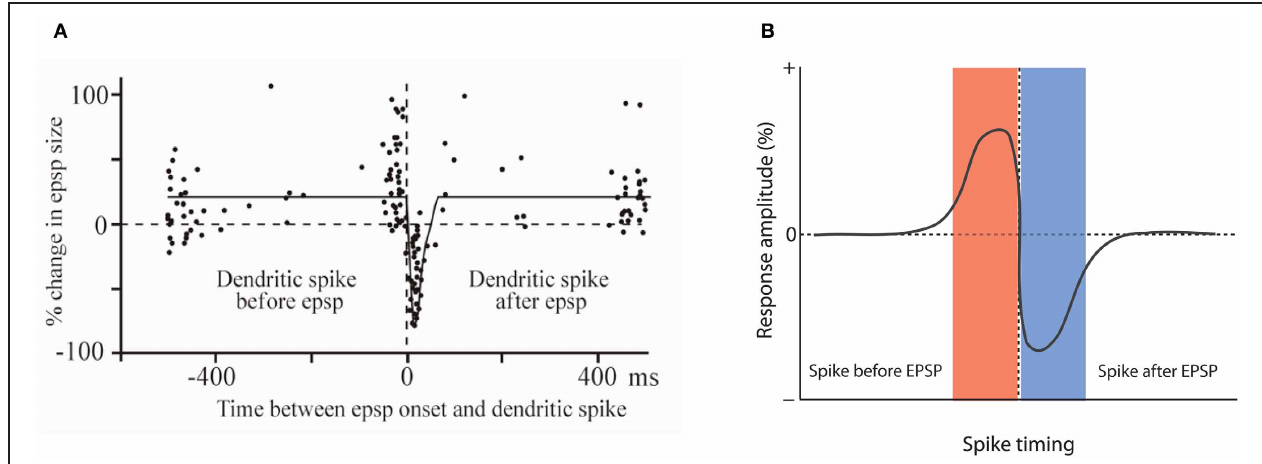
FIGURE 2 | Anti-Hebbian STDP in a cerebellum-like structure. (A) Temporal order for the induction of LTP and LTD at parallel fiber synapses onto Purkinje-like cells in the electrosensory lobe of the mormyrid fish Gnathonemus petersii . Changes in EPSP amplitudes are plotted against the delay between EPSP onset and the broad spike peak during the pairing period (360 stimuli at 1Hz). (B) Model scheme for anti-Hebbian STDP. LTP is